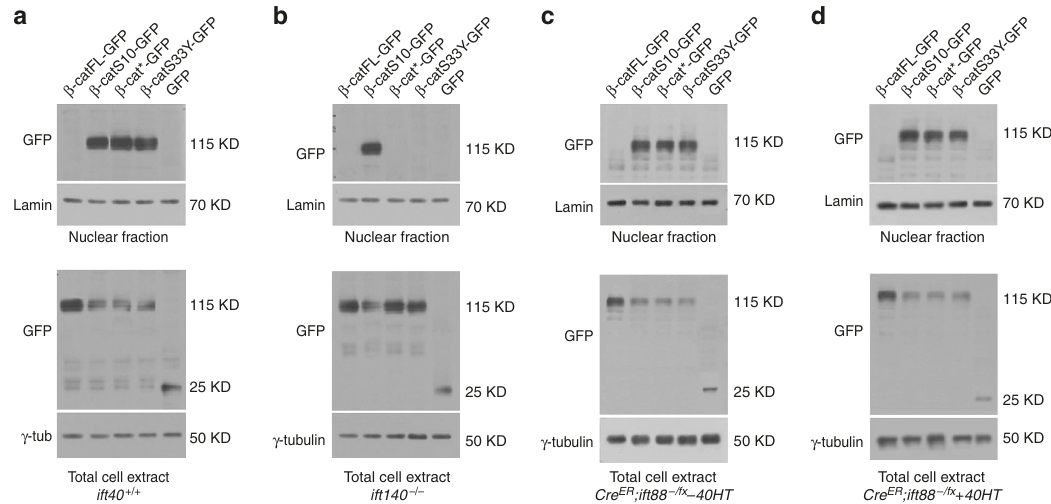
Antibodies and staining reagents . For tissue staining, primary antibodies used were: guinea pig anti-Sens (1:500, gift from H. Bellen); rat anti-Dll (1:250 from Jun Wu); rabbit anti-IFT140 (1:500, gift from G. Pazour); mouse anti-Arm (1:10, DSHB 7A1); rat anti-DE-cad (1:50, DSHB DCAD2); rat anti-Dll (1:250); mouse anti-myc (1:200, Santa Cruz, 9E10); rabbit anti-myc (1:200, Santa Cruz, d1-717); chicken anti-GFP (1:200, Aves Labs 1020); rabbit anti-RFP (1:1000, Rockland); rabbit anti-Dlg (1:200, DSHB); mouse anti-HA (1:50, Roche); rabbit-anti- β -catenin (1:100, Invitrogen AHO0462); rabbit-anti-IFT88 (1:1000, Proteintech Group 13967-1-AP); rabbit anti-Arlb13 (1:800, Proteintech Group 17711-1-AP); goat anti- γ -tubulin (1:200, Santa Cruz sc-17787) and Hoechst 33342 (10 mg/ml, 1:500). For immunoblotting, the following primary antibodies were used: mouse anti-Axin (1:500) (gift from Nusse); rabbit anti-Klp64D (1:500) (gift from Kwang Choi); mouse anti-Arm (1:1000, DSHB 7A1); mouse anti- γ -tubulin (1:1000, Sigma); mouse anti-GFP (1:1000, Roche); rabbit anti-IFT88 (1:2000, Proteintech Group); mouse anti-GST (1:1000, Invitrogen); and rabbit anti-MBP (1:1000, Sigma); rabbit anti-IFT140 (1:1000, Proteintech Group); rabbit anti β - catenin (1:800, Invitrogen); rabbit anti-laminb1 (1:1000, Abcam); rabbit anti-Axin2 (1:1000, ProSci). All fl uorescent secondary antibodies and HRP-coupled secondary antibodies were from Jackson Immuno Research Laboratories and used at 1:200.